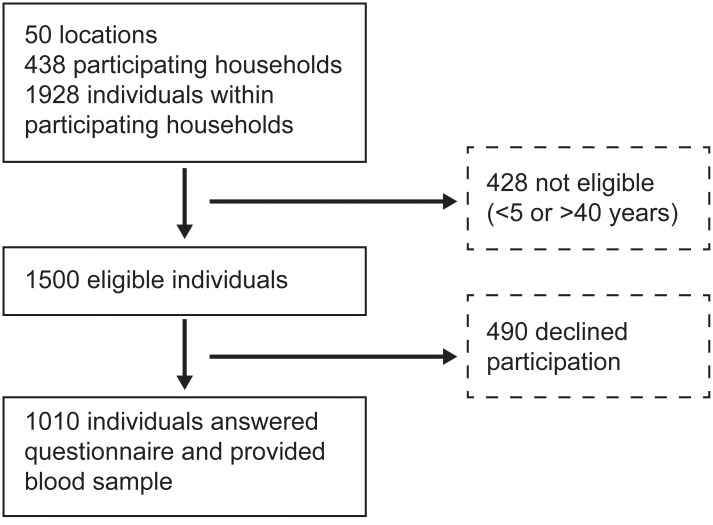
Household and participant enrollment.